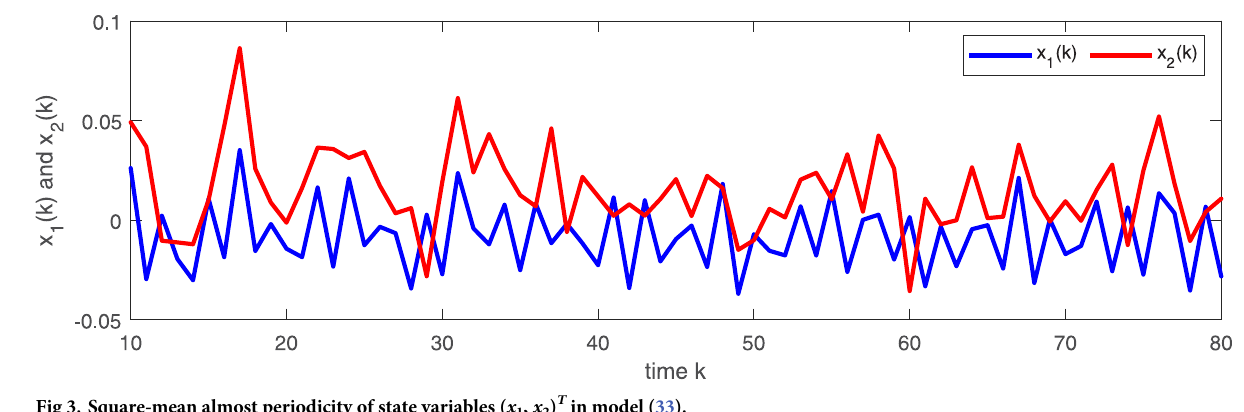
Fig 3. Square-mean almost periodicity of state variables ( x 1 , x 2 ) T in model (33).